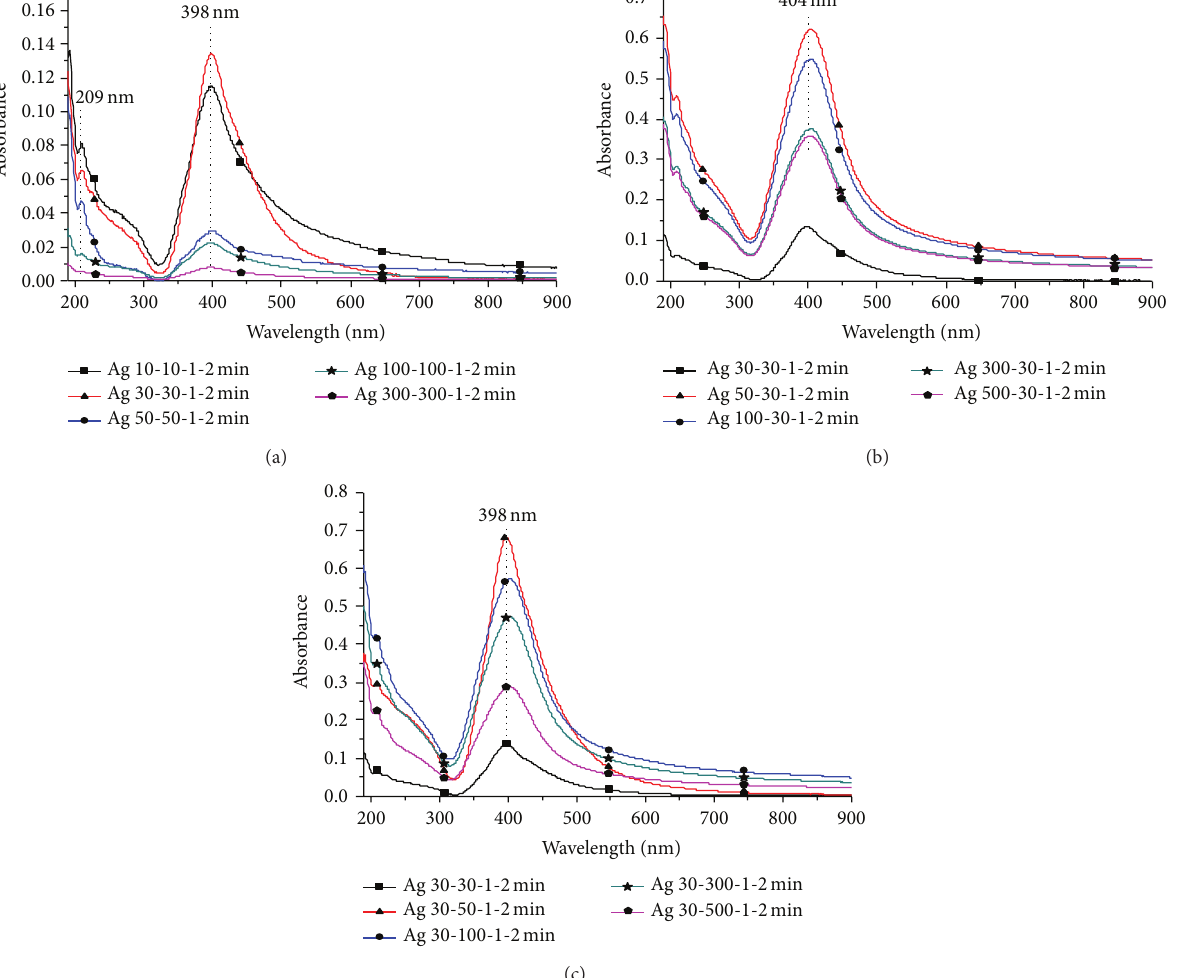
- 𝑇 in geometric proportion; (b) 𝑇 ON OFF